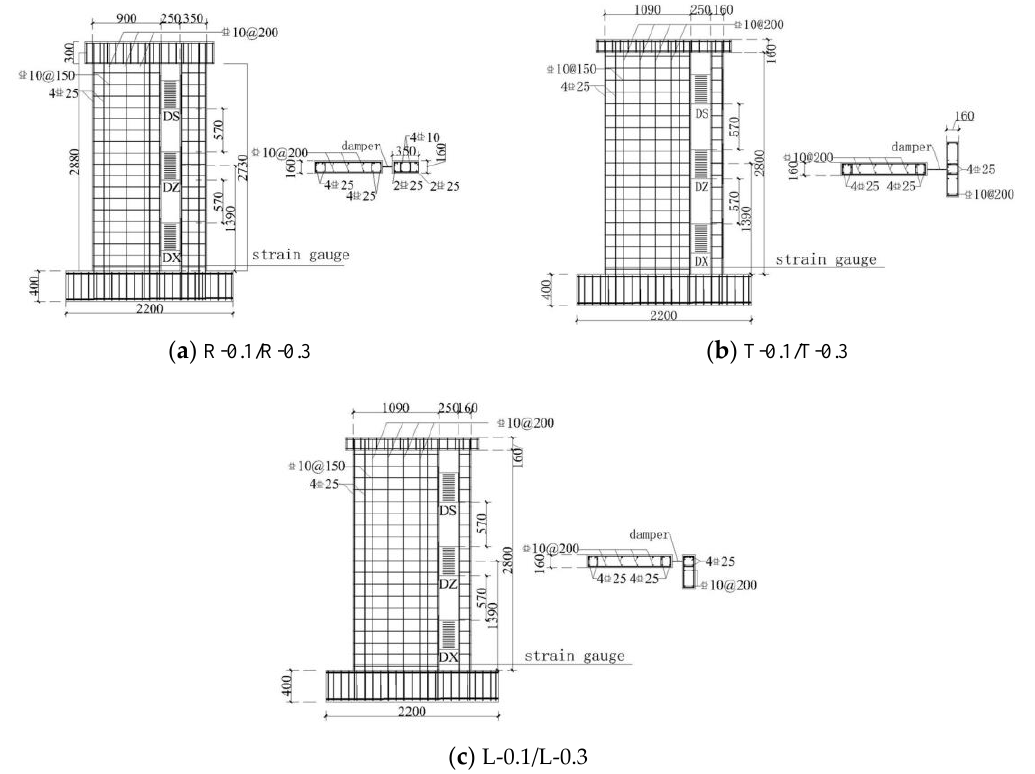
Figure 1. Design parameters of the specimen.